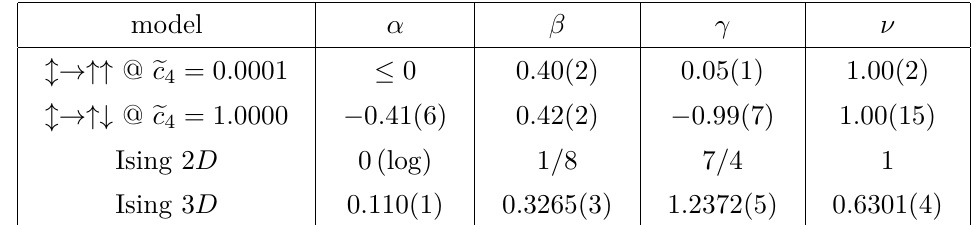
Table 2 . Comparison of critical exponents of our model and the Ising model [47].